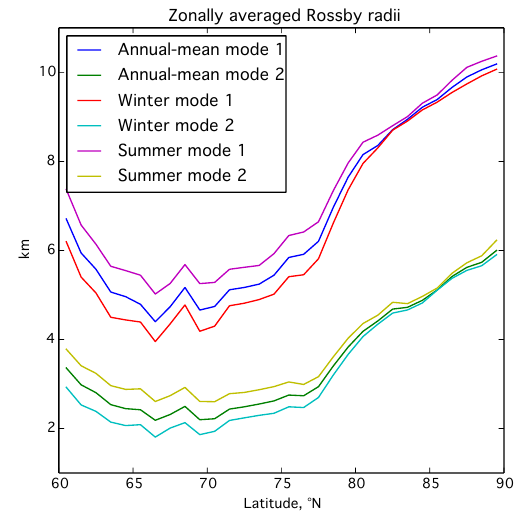
Figure 8. Zonal means of PHC Rossby radii modes 1 and